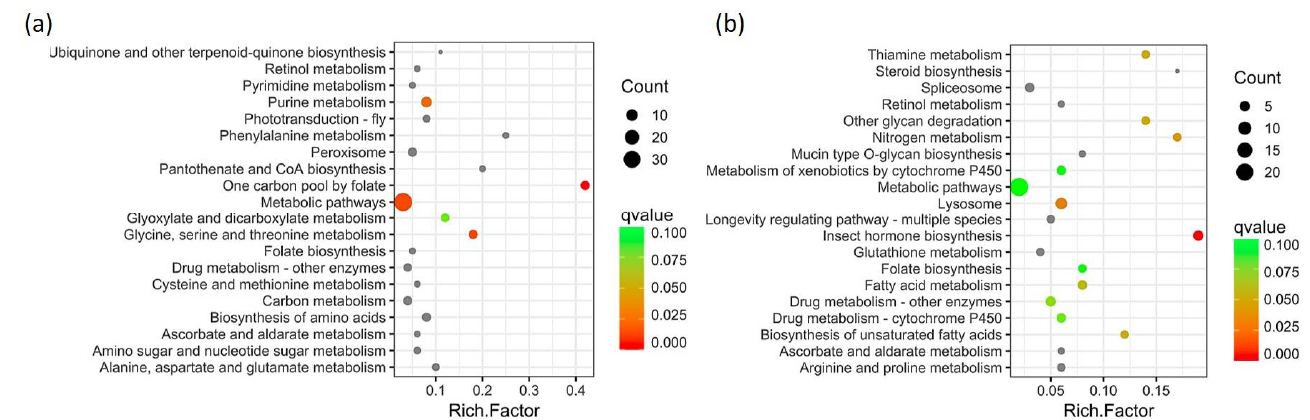
Figure 5. Scatter plot of top 20 enriched KEGG pathways among upregulated ( a ) and downregu- lated ( b ) DEGs in habanero-pepper versus control diet. The rich factor is the ratio of the number of DEGs to total gene number in a pathway. The Q-value is a corrected p -value. The color and size of the dots represent the range of q-values and the number of DEGs mapped to the indicated pathways, respectively.